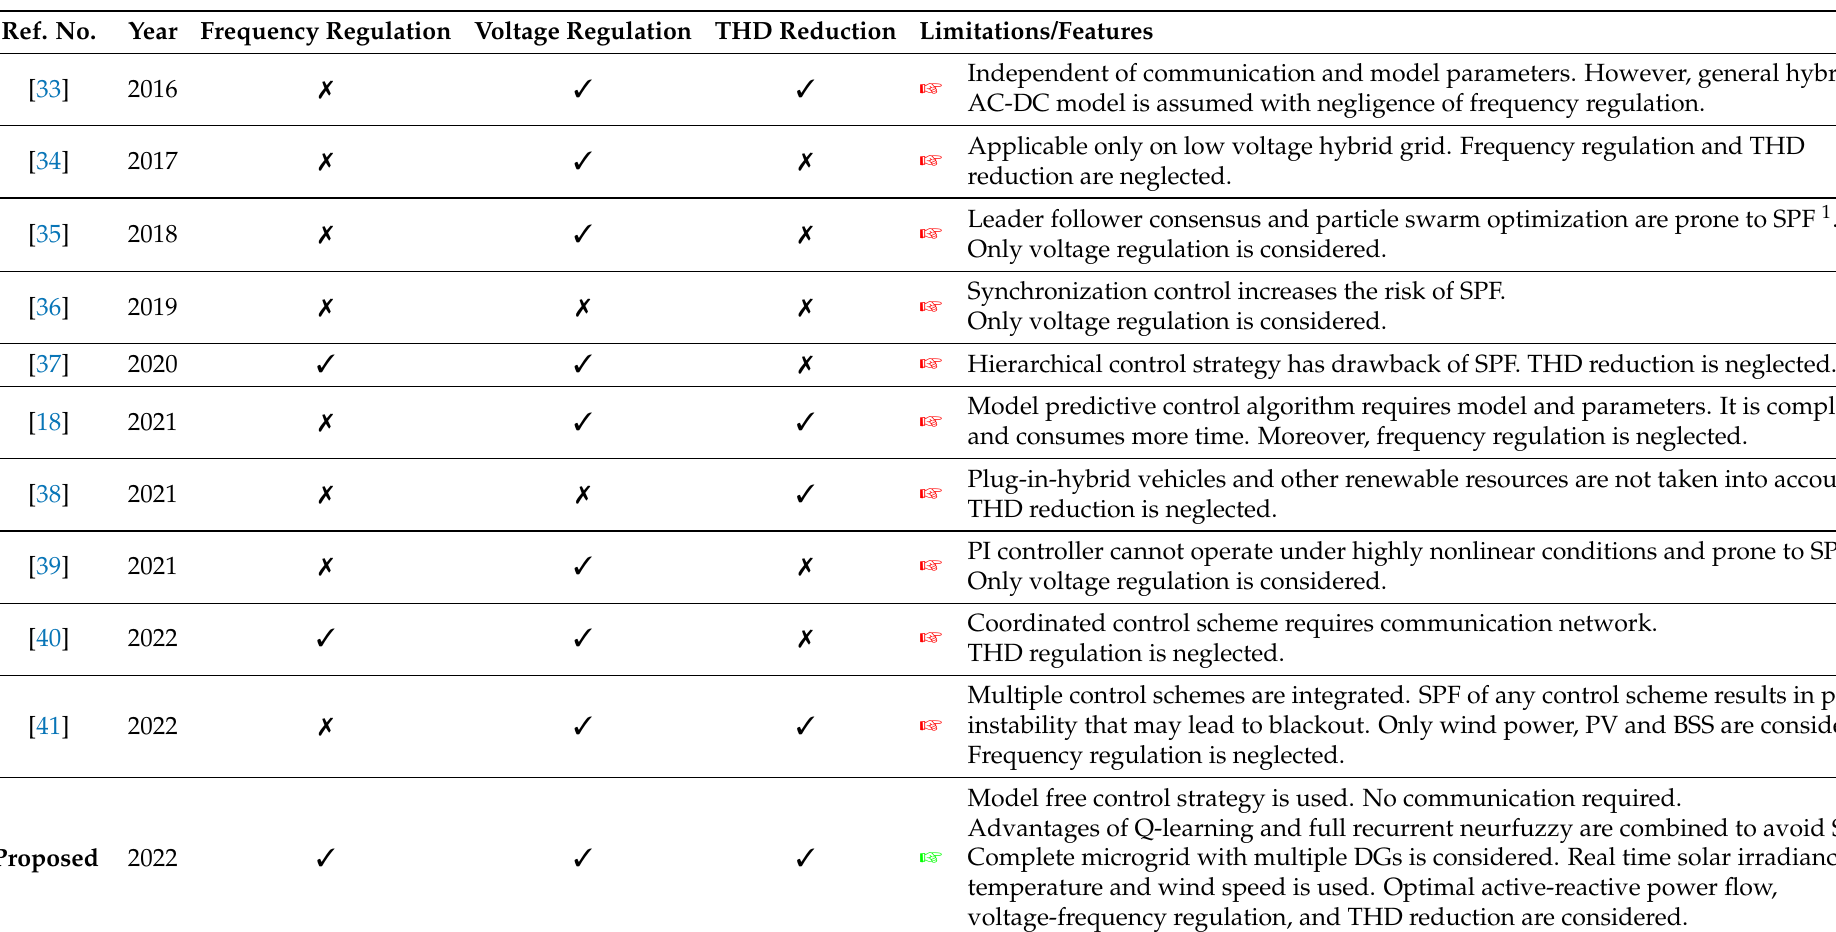
Table 1. Main contributions, features and limitations of the existing and proposed work. Ref. No.